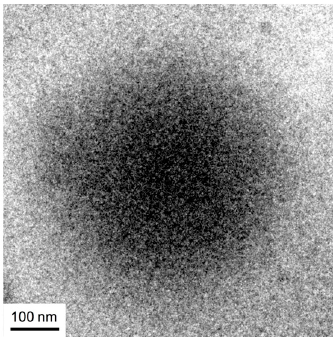
Figure 3. The cryo-TEM image of B38 26 rapidly freeze-dried from 10 mg/mL solution in HEPES buffer.